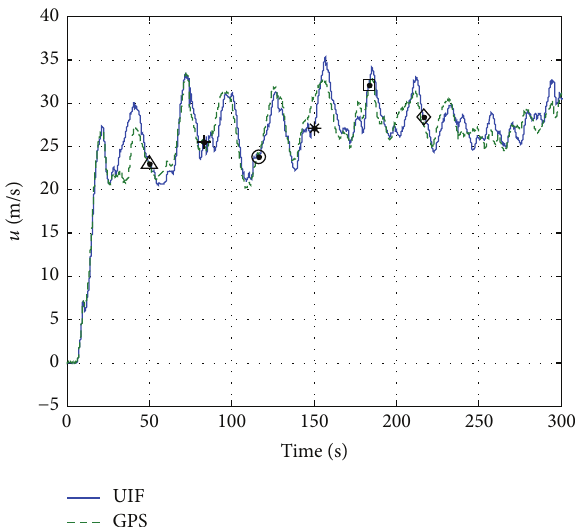
Figure 12: Comparison of attitude estimation errors with respect to lateral and vertical velocity. Table 4: Simplified formulation error statistics for Flight #1.